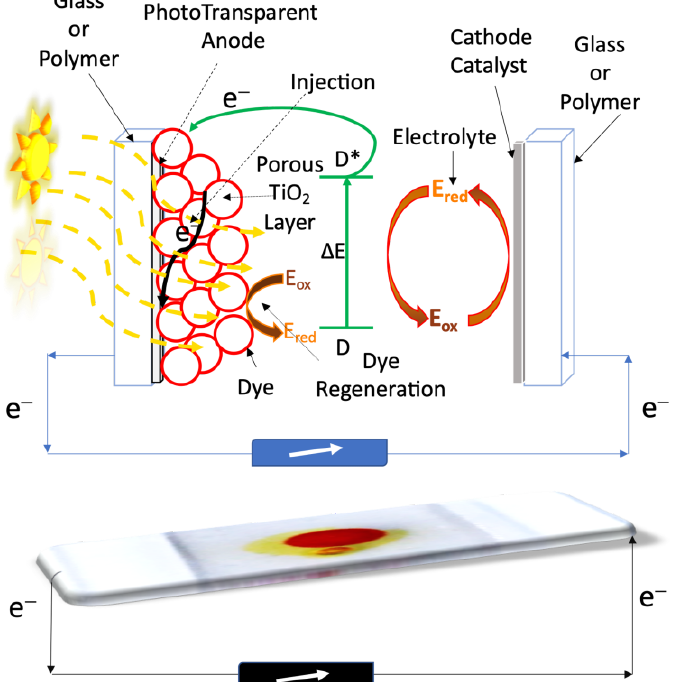
Scheme 1. Illustration of a Dye Sensitized Solar Cell (DSSC) with the main components